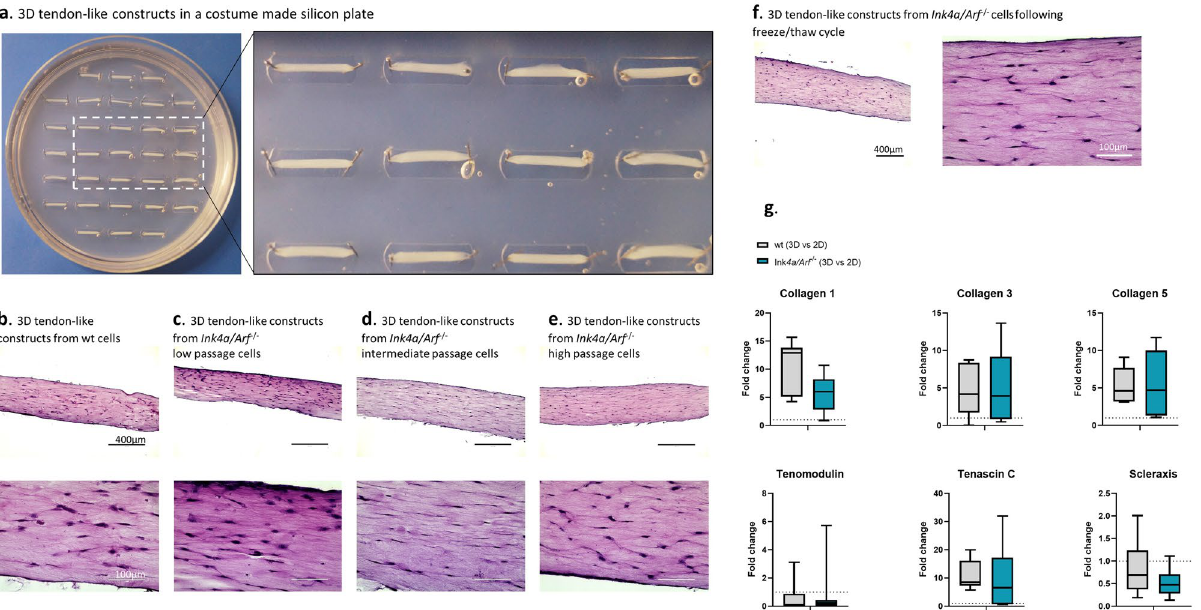
Figure 5. Tenocytes from Ink4a/Arf − / − mice can produce 3D tendon-like constructs similar to wild type (wt) cells. ( a ) The macroscopic appearance of the silicone plate with the tendon-like constructs before harvesting (left) with a close-up of the tendons in their wells (right). ( b )–( e ) Histology of H&E stained tendon-like constructs obtained from wild-type (wt) cells in a low passage ( b ) and Ink4a/Arf − / − cells in low ( c ), intermediate ( d ) and high ( e ) passages (top row: scale bar 400 µm, bottom row: scale bar 100 µm). ( f ) 3D tendon-like constructs of Ink4a/Arf − / − tenocytes in an intermediate passage following freeze and thaw cycle showed analogous cell and fiber arrangement to 3D tendon-like constructs of wt or Ink4a/Arf − / − cells, which had not undergone a freeze–thaw cycle (left micrograph: scale bar = 400 µm, right micrograph: scale bar = 100 µm). ( g ) qPCR analysis of tendon markers- Col1 , Col3, Col5, Scx, Tnmd and Tnc presented as fold change (FC) in gene expression between 3 and 2D, for wt and Ink4a/Arf − / − cells individually. The dotted line in each graph represents a FC of 1 (no difference between 2 and 3D gene expression). The expression in Col1 , Col3 , Col5 and Tnc , but not in Tnmd and Scx , was significantly higher in 3D than 2D culture for both wt and Ink4a/Arf − / − cells (for mean normalized mRNA expression and p-values, see Table 2).